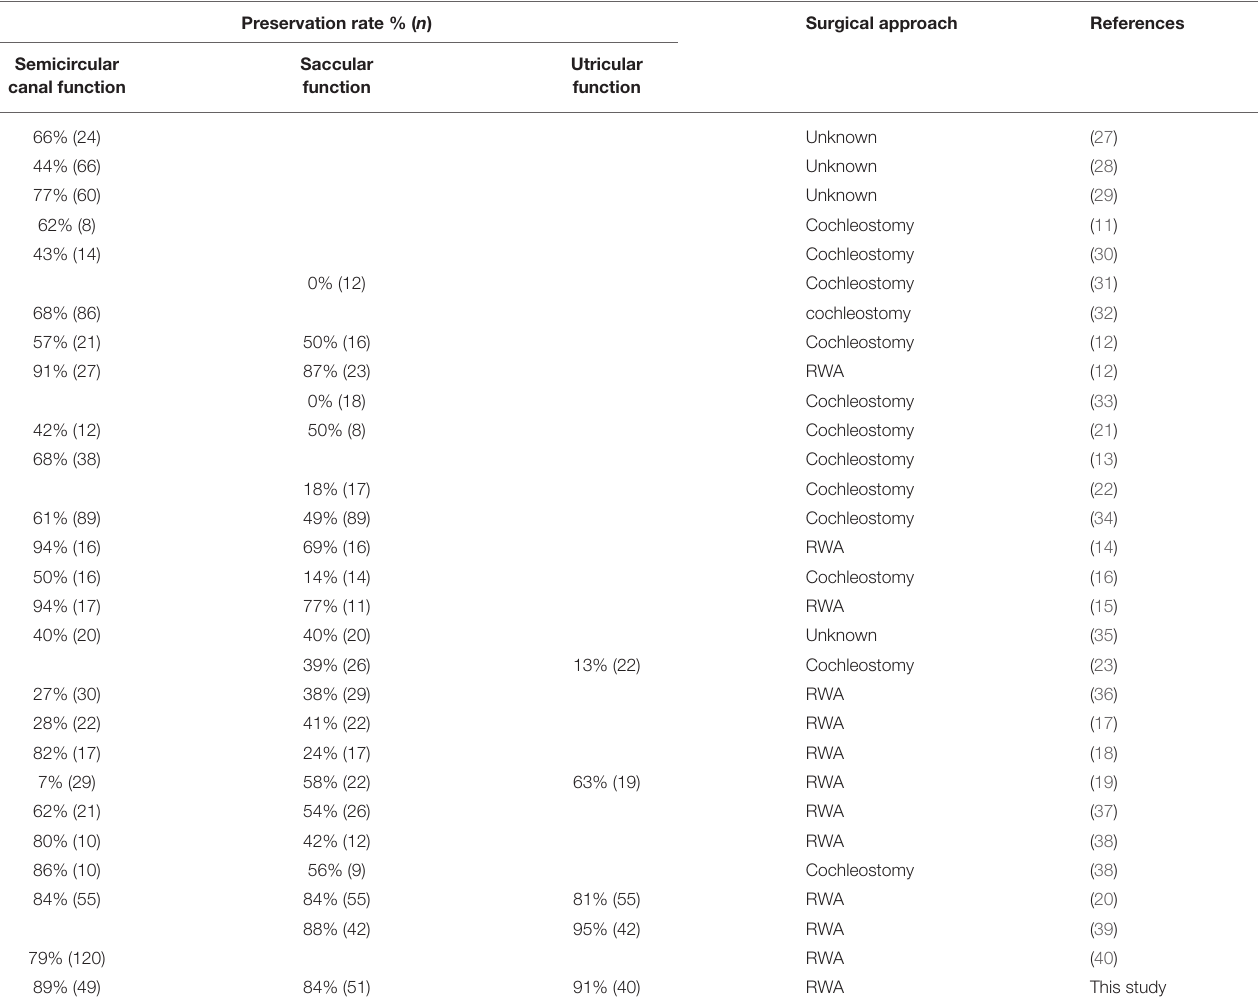
TABLE 3 | The frequencies of post-operative vestibular preservation in the literature. Preservation rate % ( n ) Surgical